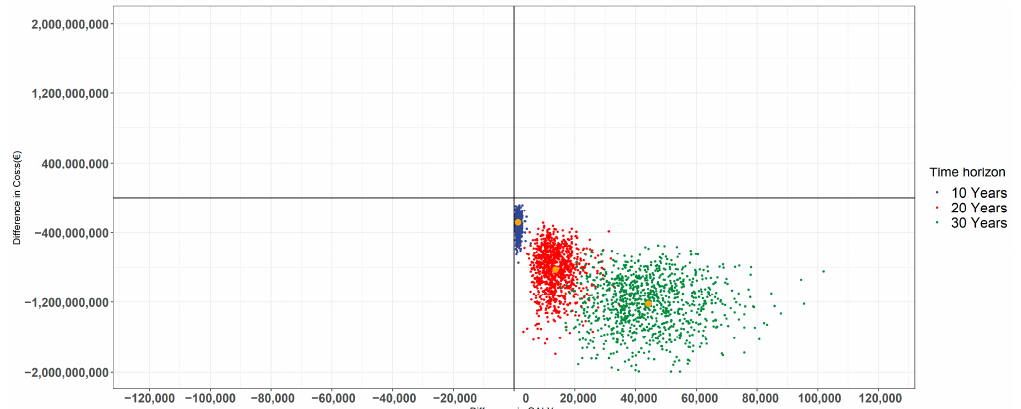
Figure 3. Results of the probabilistic sensitivity analysis showing the impact of applied time horizon on the distribution of expected population-level cost savings and gained QALYs on the X-Y-plane using Scenario I (current situation vs. a 10%-unit increase in the proportion of adult population using at least one whole grain servings a day) as an example. Blue, red, and green colors stand for 10-year, 20-year, and 30-year time horizons, respectively.